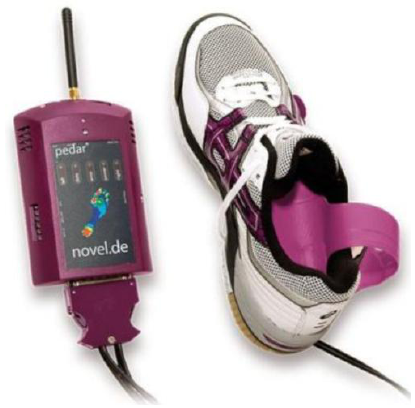
Figure 6. Foot-pressure monitoring system, Pedar (Novel, Munich, Germany, www.novel.de).